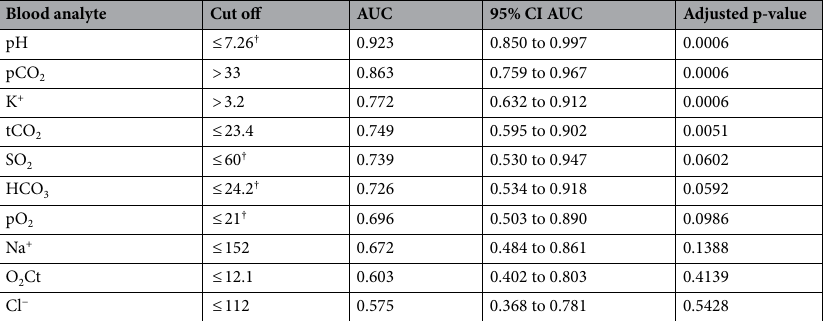
Table 4. Results of the analysis of the ROC curve of each blood gases biomarker in a sample 51 sea turtles with area under the curve (AUC, determined according to the non-parametric method of DeLong and Clarke- Pearson), its 95% confidence interval, the threshold (cut off), and adjusted p value, as mortality predictors. † Value out of range 23 .